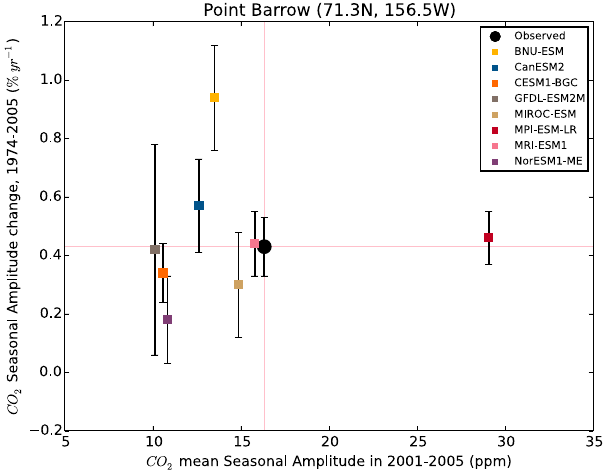
Figure 10. CO 2 mean seasonal amplitude (ppm) during 2001–2005 and increase in CO 2 seasonal amplitude at Pt. Barrow during 1974–2005 (%yr − 1 , linear trend) from eight CMIP5 ESMs and ob- servation. The big black circle represent surface CO 2 observation at Point Barrow, Alaska (71.3 ◦ N, 156.5 ◦ W; 11m above sea level). The colored squares represent the CO 2 output at lowest model level (four models at 1000hPa, and four at 925hPa) at the original grid that covers Point Barrow from each of the eight models. Error bars indicate ± 1 standard error in the trend calculation. Compared to the surface observation, only MPI-ESM-LR overestimate the CO 2 mean seasonal amplitude at Point Barrow, while the other models underestimate this amplitude. Models split between overestimating and underestimating the CO 2 seasonal amplitude increase at Point